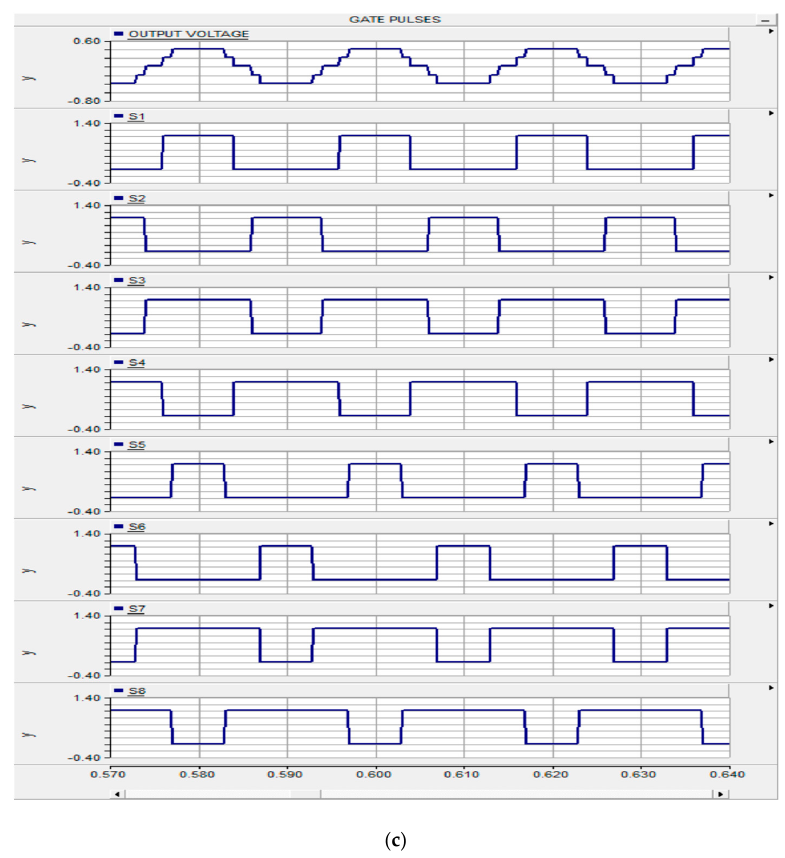
Figure 8. ( a ) Power circuit of 5-level CHB-MLI; ( b ) control circuit of 5-level CHB-MLI; ( c ) phase output voltage waveform of 5-level CHB-MLI. Table 4. Voltage levels of 5-level CHB-MLI and switching states.